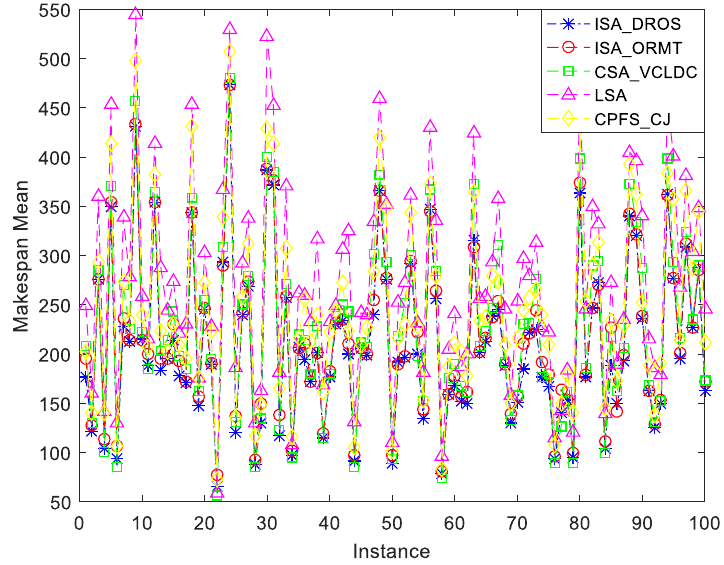
Figure 13. The average time required by each of the five algorithms to process products.